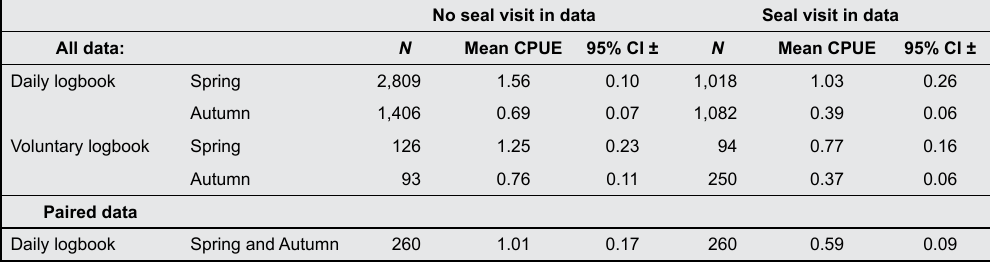
Table 2. Mean CPUE (kg herring m net -1 day -1 ) in the daily logbook (all data) and in the voluntary logbook (paired data), for days with seal visits (i.e. notes of seal visits in logbooks) and